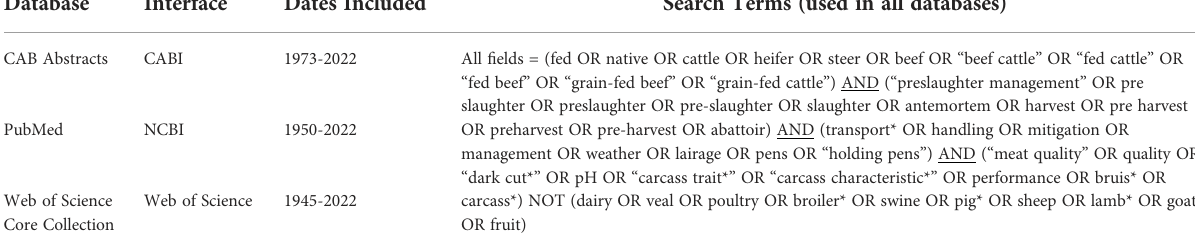
TABLE 1 Database and search string information for a scoping review on the impact of pre-slaughter management factors on meat quality outcomes in cattle raised for beef.